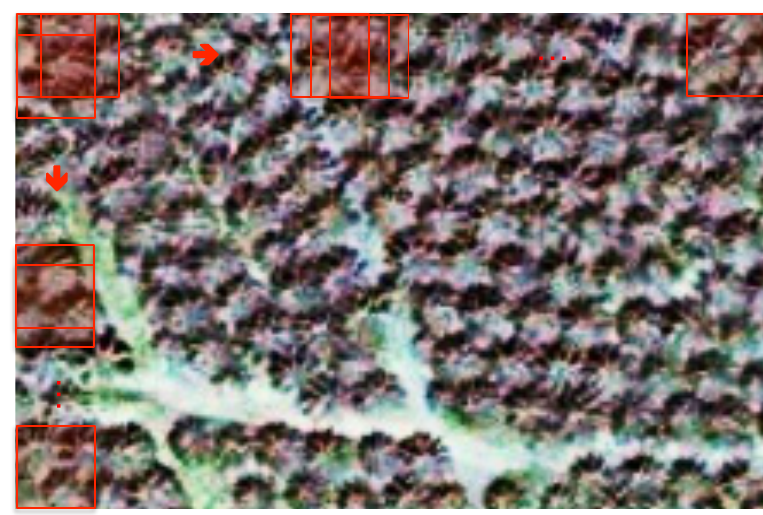
Figure 4. The sliding window technique.